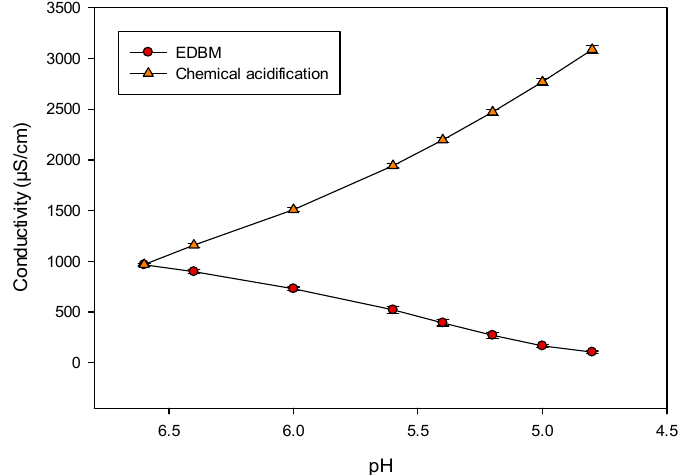
Figure 1. Evolution of whey protein isolate (WPI) solution conductivity during chemical and EDBM acidifications.